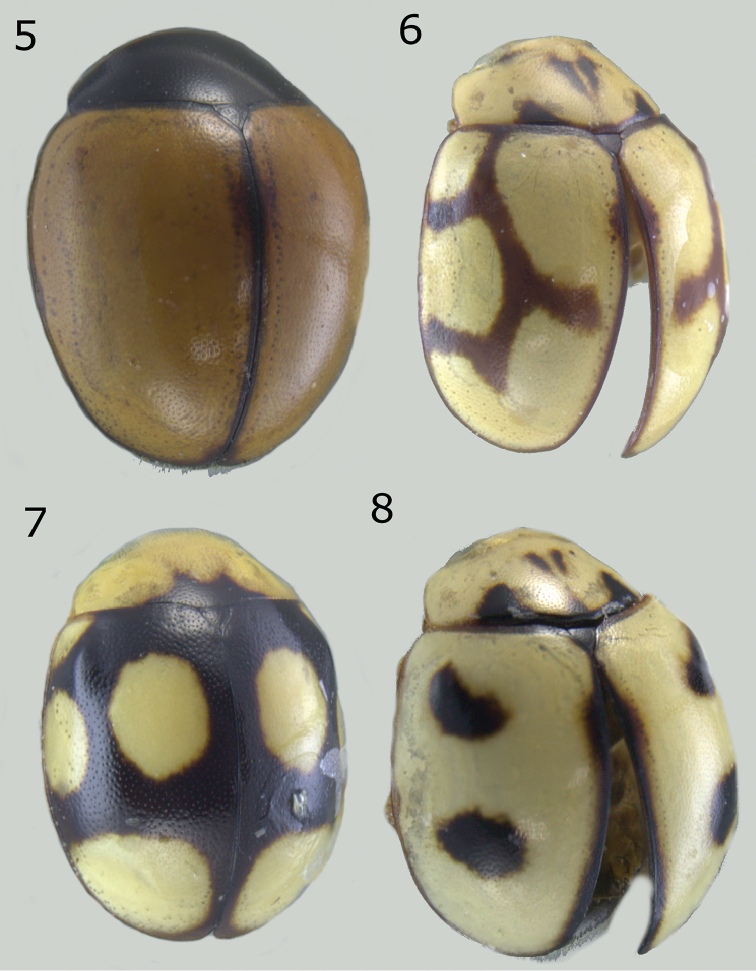
Brachiacantha sp. 5Brachiacantha
bipartita, female 6Brachiacantha
aperta, female 7Brachiacantha
isthmena sp. nov. 8Brachiacantha
cachensis.